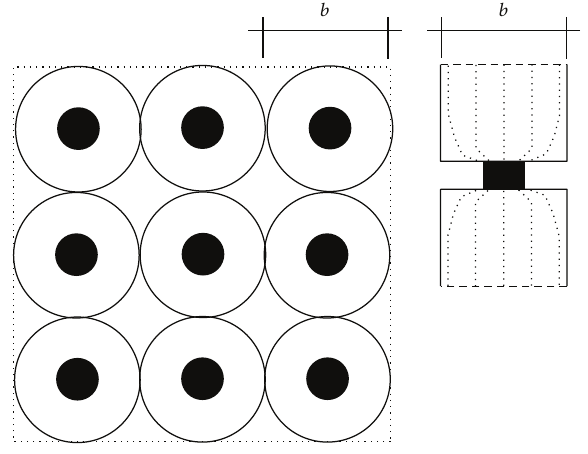
Figure 1: Schematic view of a -spot